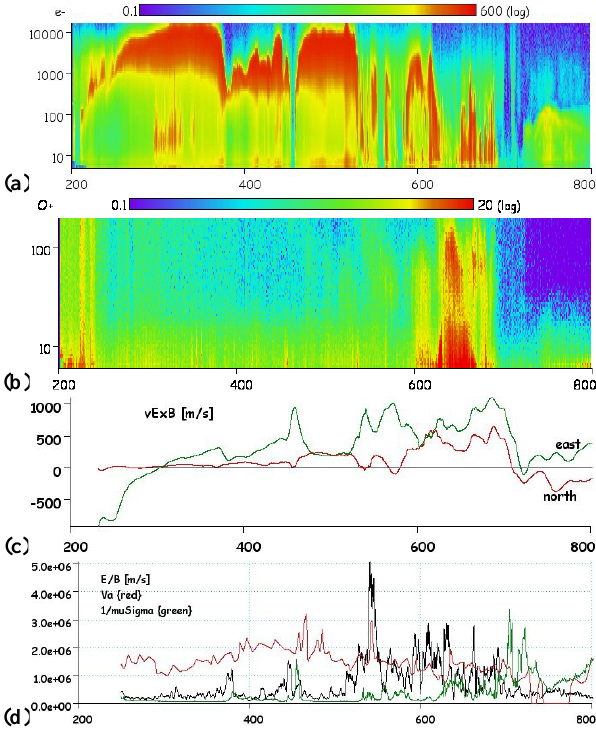
Fig. 1. Flight data overview as a function of flight time [s] from T+200s to T+800s. (a) , (b) : Energy spectra [eV] of electrons and oxygen, integrated over all pitch angles [color bar proportional to differential energy flux eV/cm 2 /s/sr/eV, arbitrary gain.] (c) DC electric field perpendicular to B o , plotted as velocity [m/s]. (d) In- verse conductivities, plotted as velocity [m/s]: E/B, black; V A , red; 1/( µ o 6 P ), green.